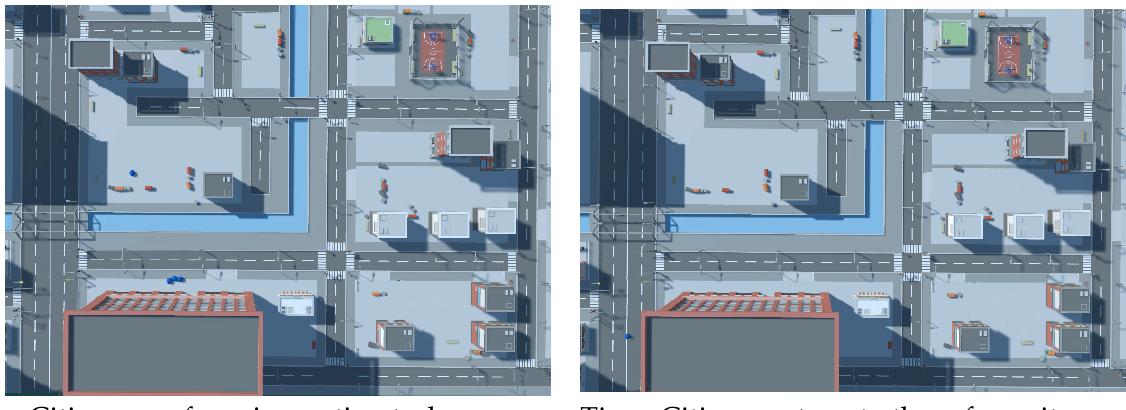
Figure 7. ( a ) Map of Sweet Well City; ( b ) distribution of citizens in the refuge site at different mo- ments; ( c ) distribution of citizens around CompanyType1-1.